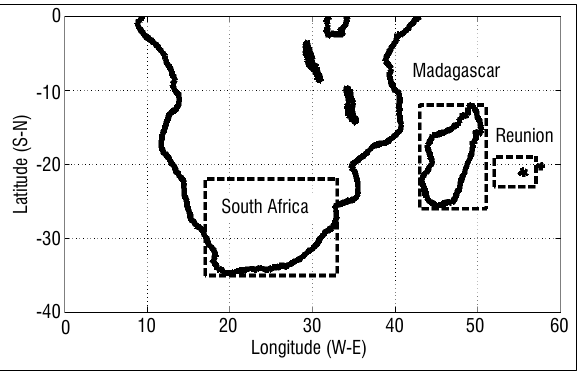
Figure 1: Geographical locations of the three study regions.